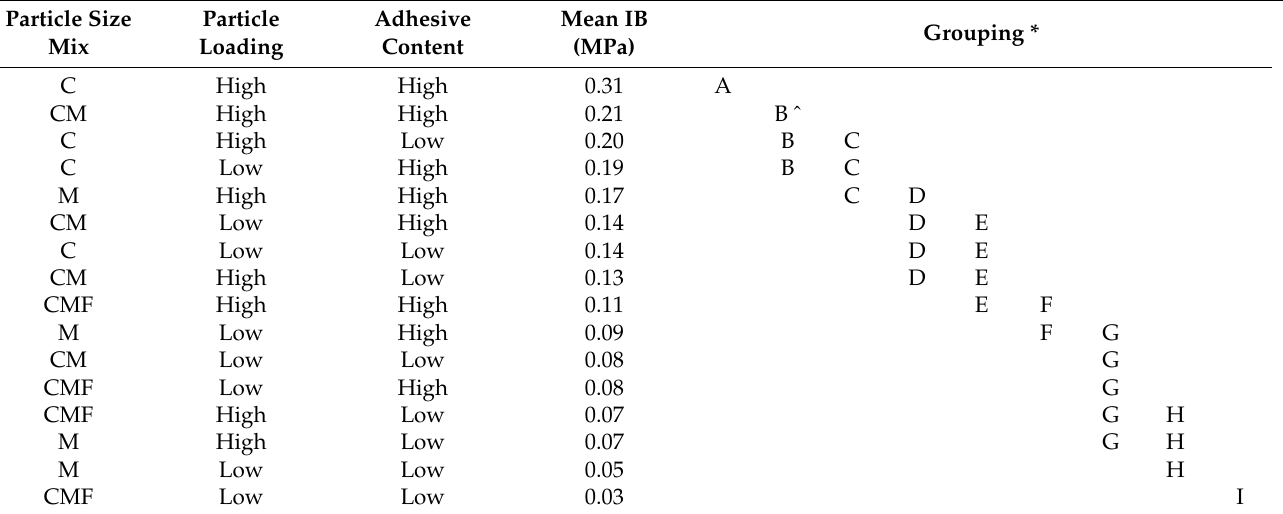
Table A2. Fisher LSD grouping information at 95% confidence level of